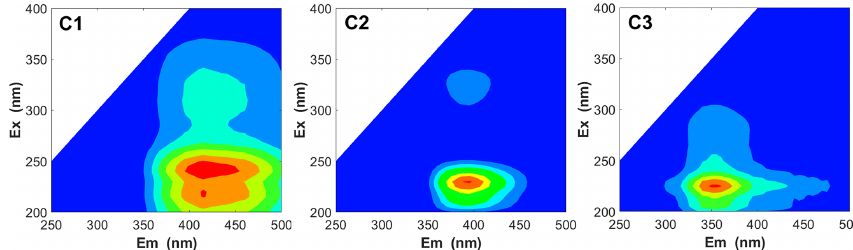
Figure 8. The PARAFAC analysis identified fluorescence components (C1, C2, and C3) for all WSOC samples.